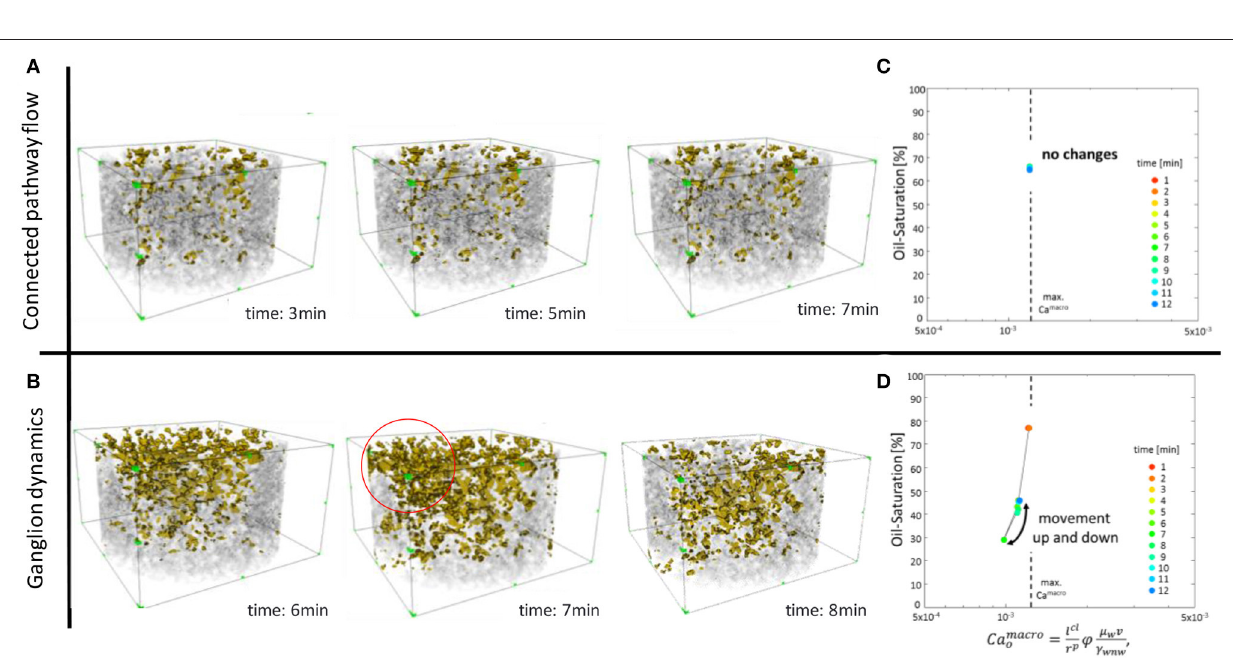
FIGURE 14 | Pressure drop and saturation from Figure 11 show long time periods without any change but also time periods with discrete events. Based on the associated dynamics at the pore scale, respective pore scale flow regimes can be categorized into predominantly connected pathway (A) and ganglion dynamics (B) . A “phase diagram” can be developed in analogy to Figure 12 but now for the whole field of view instead of individual clusters only, where connected pathway flow is characterized by a fixed point (C) and ganglion dynamics as trajectories (D) in the saturation-macroscopic capillary number space. impacts the cluster-based capillary number (Hilfer and Oren, where L cluster is the length of the respective oil cluster, µ w 1996; Armstrong et al., 2014b). the wetting phase viscosity, v w the wetting phase Darcy velocity, σ ow the wetting/non-wetting phase interfacial tension and θ the contact angle, and p c the capillary pressure at